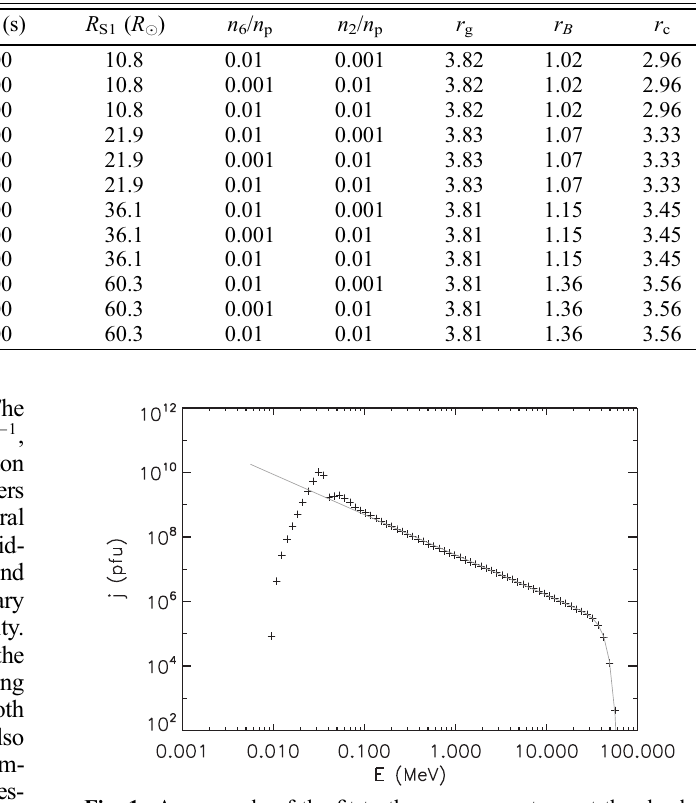
Fig. 1. An example of the fit to the energy spectrum at the shock. The case considered is Run